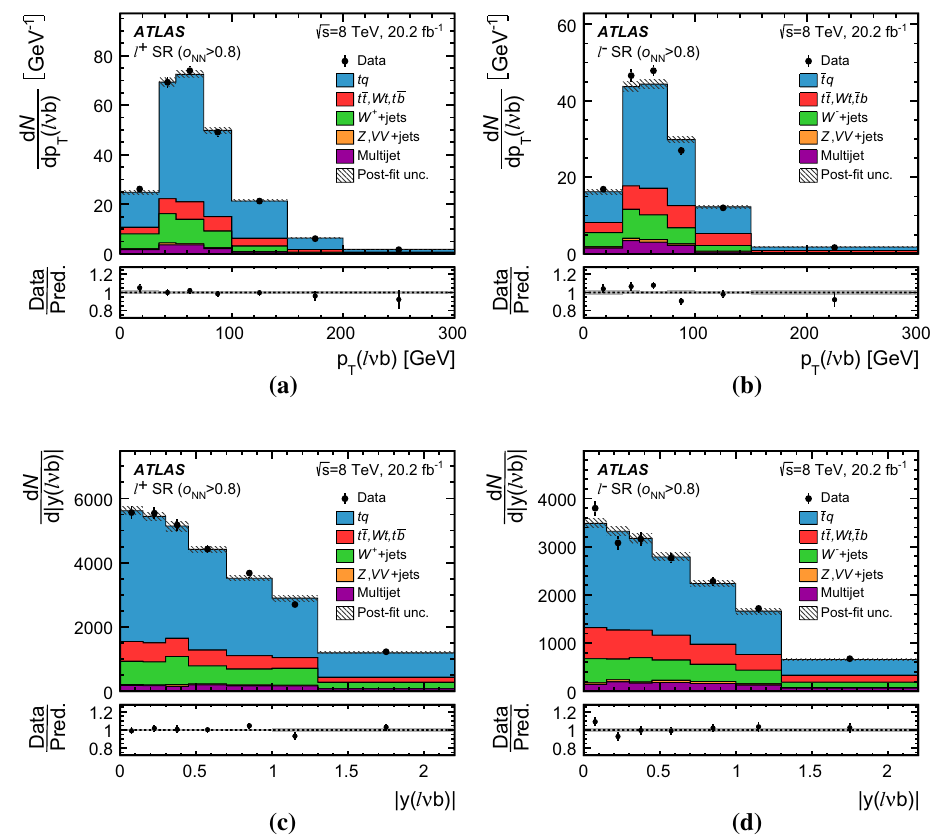
Fig. 14 Measured distributions of ( a , b ) p T ((cid:5)ν b ) and ( c , d ) | y ((cid:5)ν b ) | for ( a , c ) (cid:5) + and ( b , d ) (cid:5) − events in the signal region (SR) after a cut of O NN > 0 . 8. The distributions are compared to the model obtained from simulated events. The simulated distributions are normalised to the event rates obtained by the fit to the discriminants. The hatched